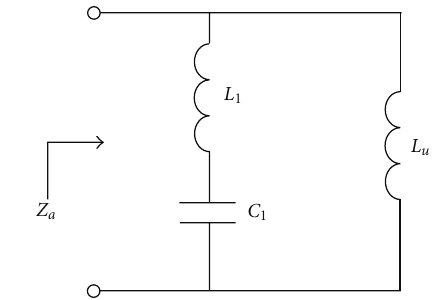
Figure 4: Equivalent circuit of open resonator system in Figure 3.